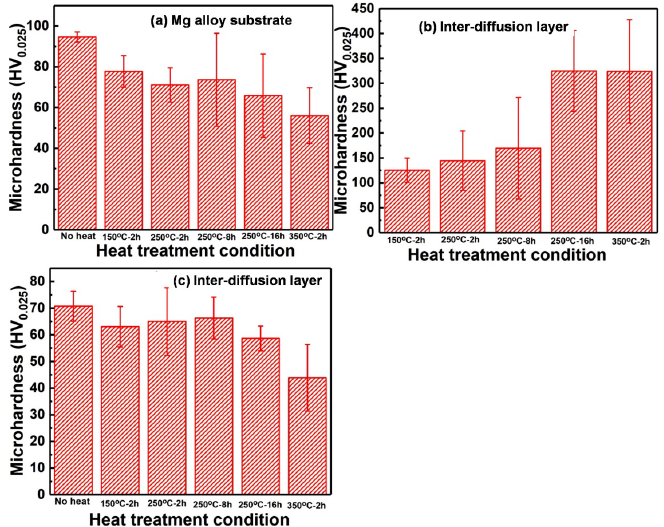
Figure 4. Microhardness of Zn coatings after different heating conditions.